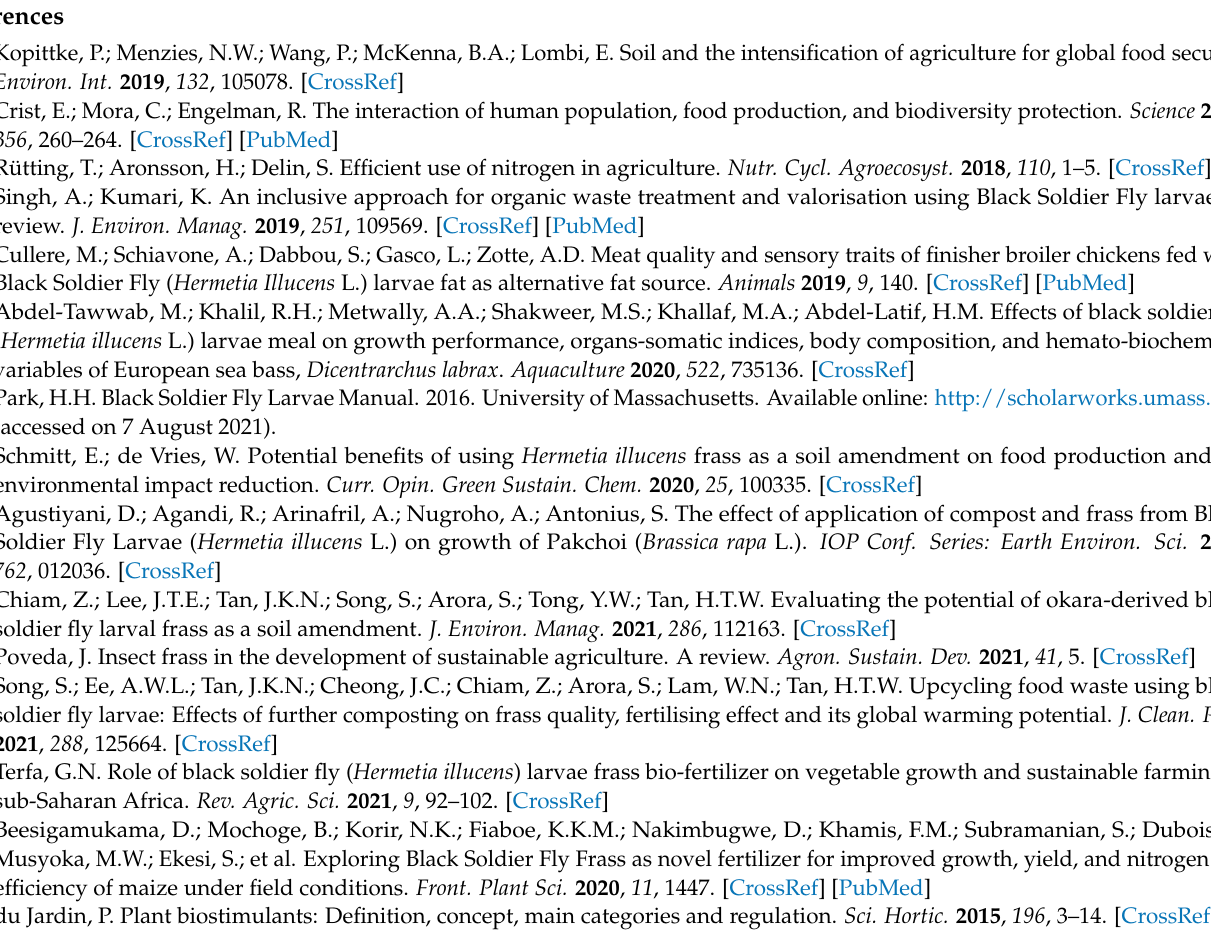
Table S2: p-values obtained from ANOVA examining the effects of potting mix, fertilizer treatments, and the interaction term on shoot dry matter of basil, lettuce, and parsley, Figure S3: Meta analysis using REML function in Genstat of effects on shoot dry weight of adding fertilizers to 10 different plant species grown in high organic content growing medium, Figure S4: Comparison of shoot and root growth (mg dry weight) of basil, lettuce and parsley grown in two experimental potting mixes assigned as having “Low” and “High” nutrient